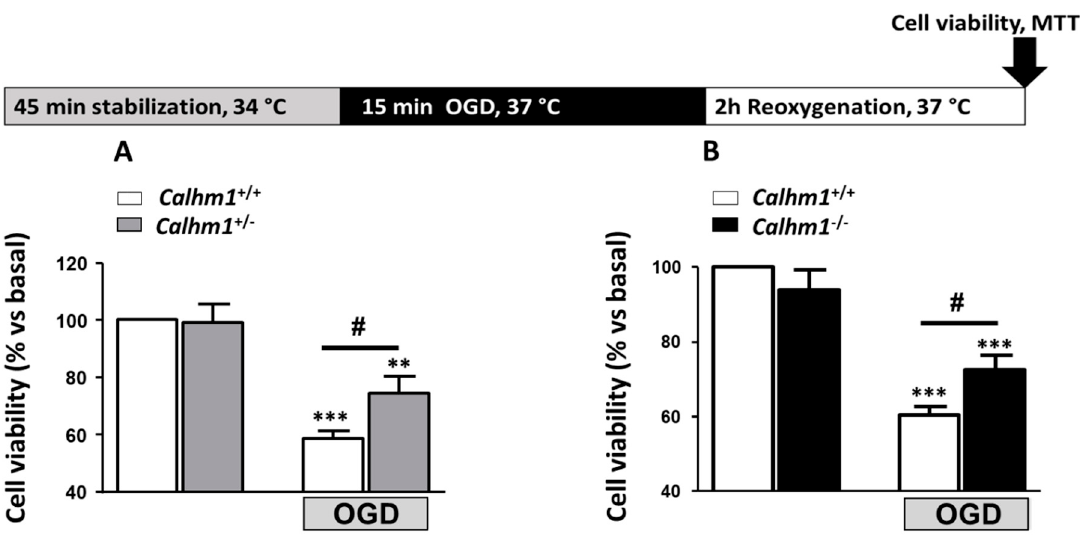
Figure 1. Calhm1 − / − mice present neuroprotection against cell death elicited by oxygen and glucose deprivation followed by reoxygenation (OGD / Reox) in hippocampal slices. The top part of the figure shows a schematic representation of the OGD / Reox protocol used, as described in materials and methods. ( A ) Represents cell viability measured by MTT reduction in hippocampal slices from Calhm1 +/+ and Calhm1 +/ − mice under basal conditions or exposed to the OGD / Reox protocol. OGD / Reox-induced cytotoxicity is prevented in Calhm1 +/ − hippocampal slices. Data are the mean ± S.E.M of seven di ff erent animals; all variables were run in parallel. *** p < 0.001 and ** p < 0.01 in comparison to basal; # p < 0.05 respect to Calhm1 +/+ OGD. ( B ) Hippocampal slices from Calhm1 − / − mice subjected to OGD / Reox show higher cell viability when compared to those obtained from Calhm1 +/+ mice. Data represent the mean ± S.E.M of 7 di ff erent animals; all variables were run in parallel. *** p < 0.001 versus basal; # p < 0.05 respect to Calhm1 +/+ OGD. One-way ANOVA followed by Newman–Keuls was performed. Data were normalized to Calhm1 +/+ , which was considered as 100% of